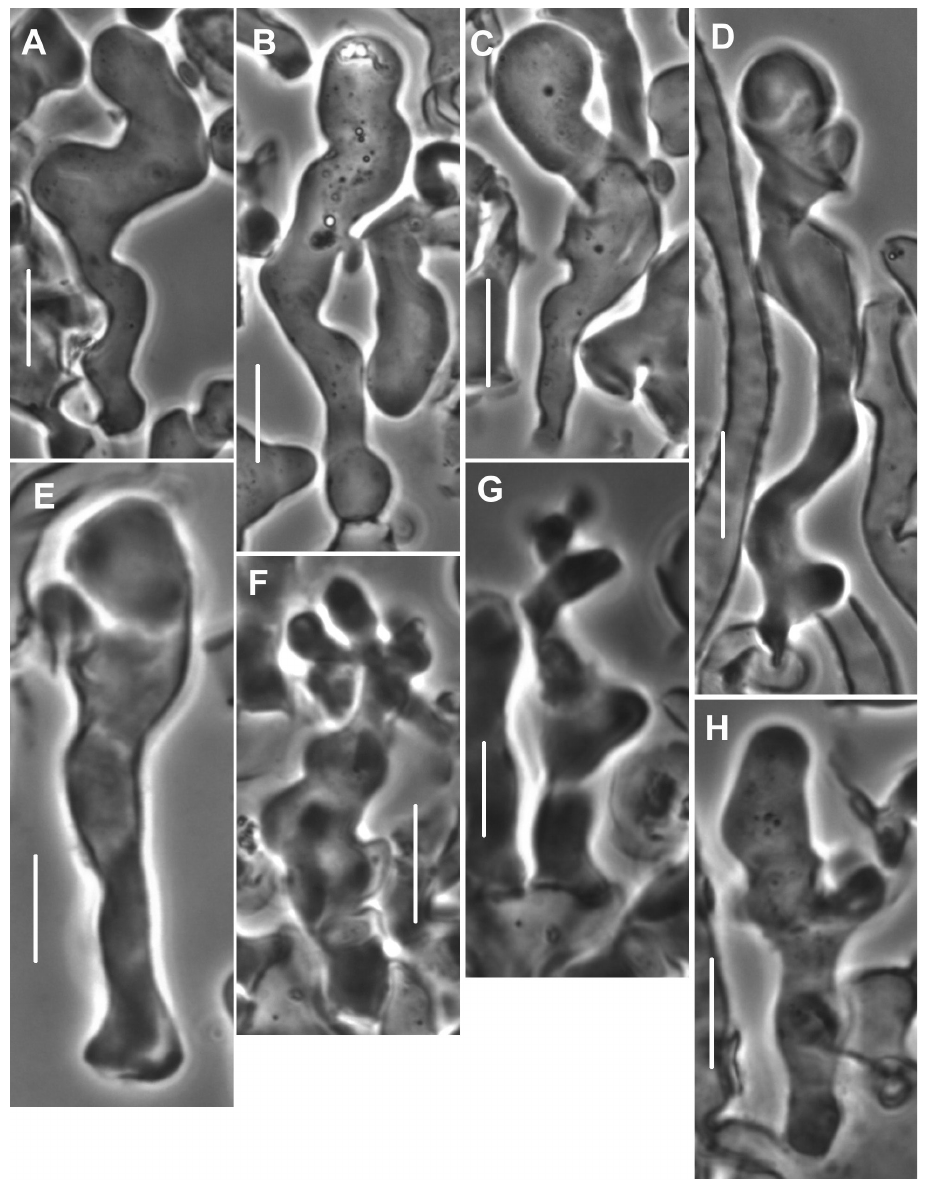
Figure 13. Mycetinis applanatipes . Pileipellis structures. A–D Lobate hyphal termini E–H Structures with dense protoplasm, usually lobate or branched. Standard bars = 10 µm. DED 6628 (SFSU-F- 024637).